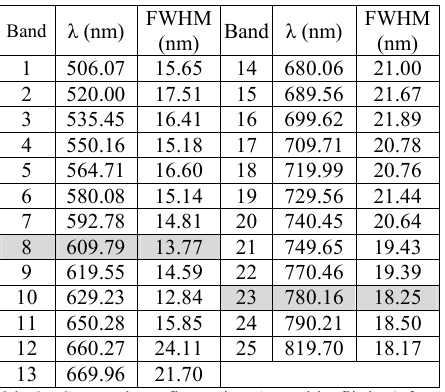
Table 3. Spectral configuration 1 used in flight (cfg.